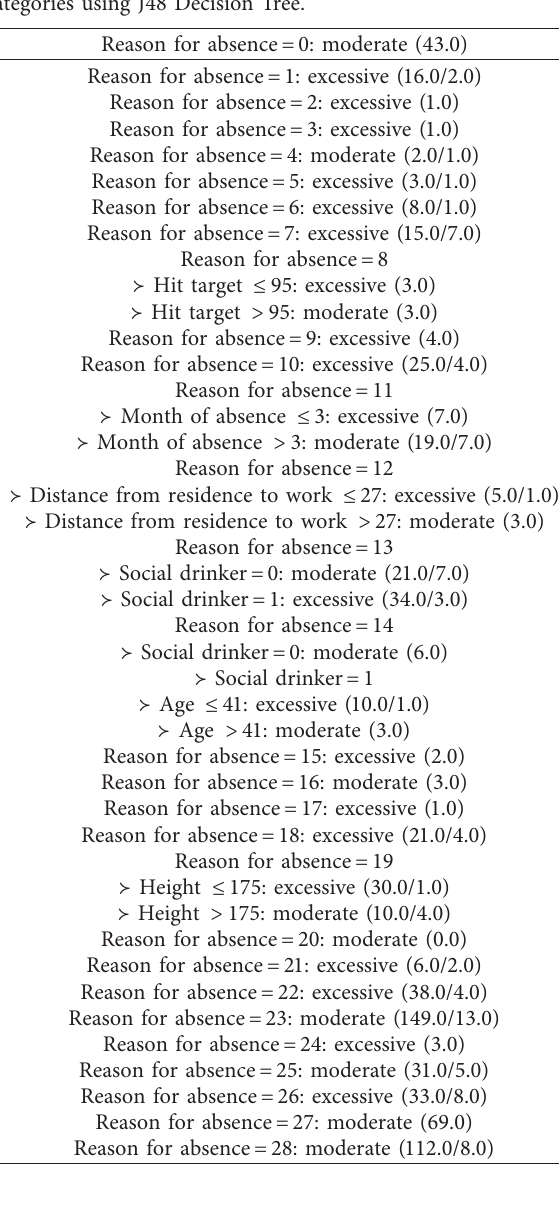
Table 2: Reasons of absence that results into moderate or excessive categories using J48 Decision Tree.